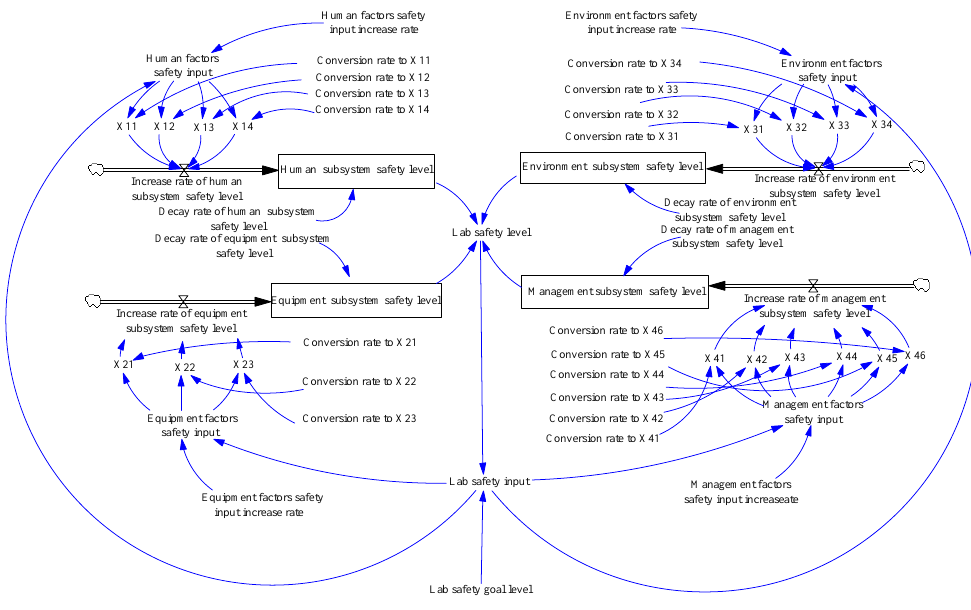
Figure 6. Stock and flow diagram of the SD model.